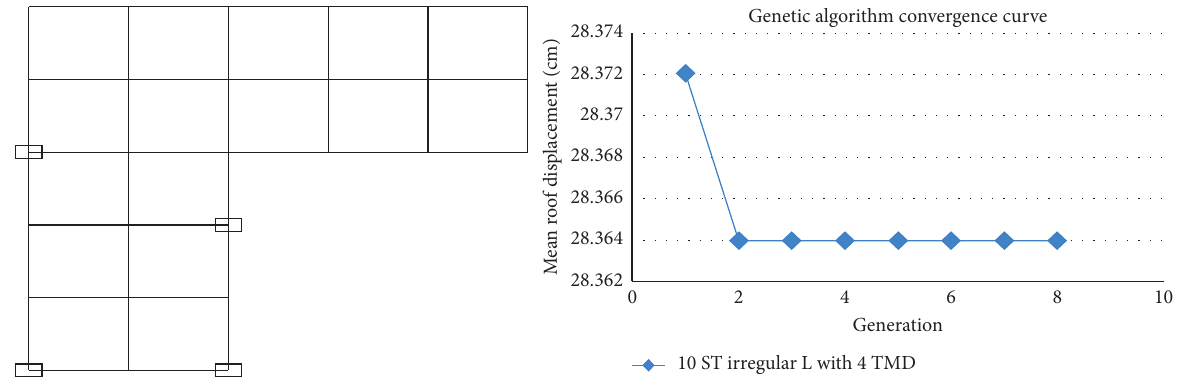
Figure 19: Convergence diagram of the ten-story model with 4 dampers in genetic algorithm (right) and damper optimal positions (left).